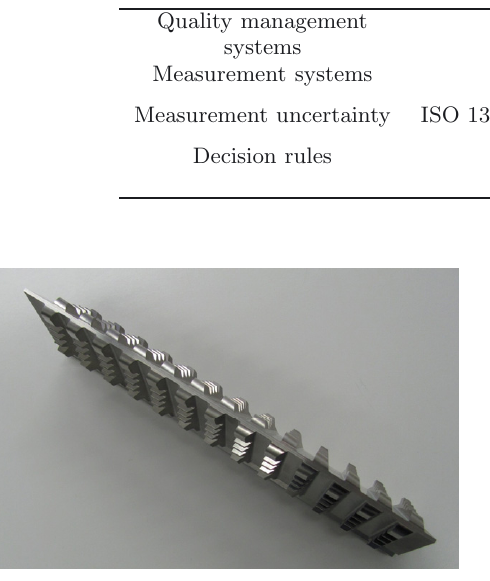
Fig. 1. Broach that has to be